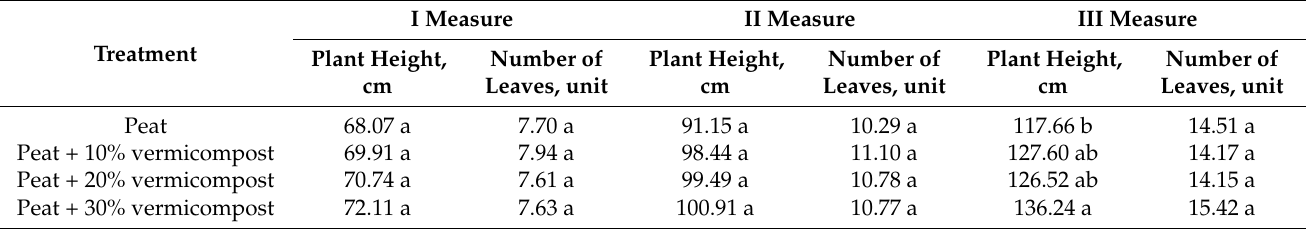
Table 4. The effect of peat–vermicompost substrate on plant height and number of